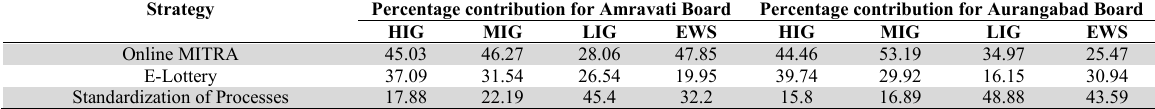
Percentage contribution of every strategy (Amravati and Aurangabad Board) Strategy Percentage contribution for Amravati Board